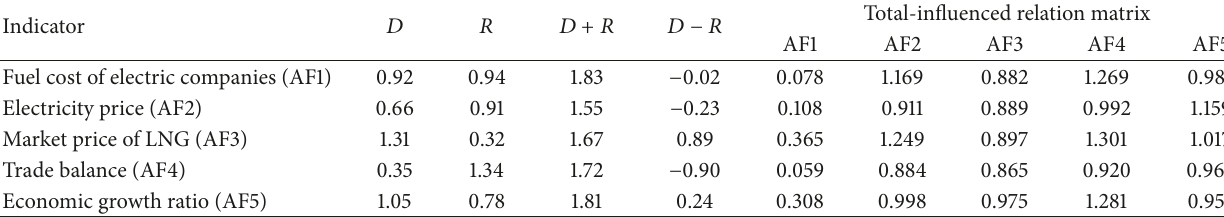
Table 13: The result of Fuzzy-DEMATEL analysis for Affordability (Case 2 ).